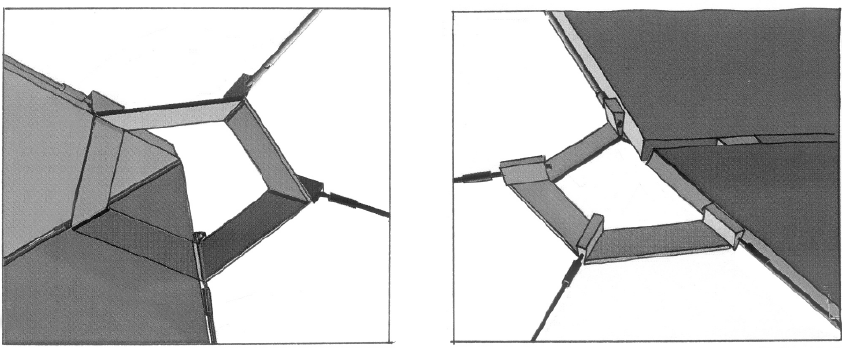
Figure 7: Single sided socket as a